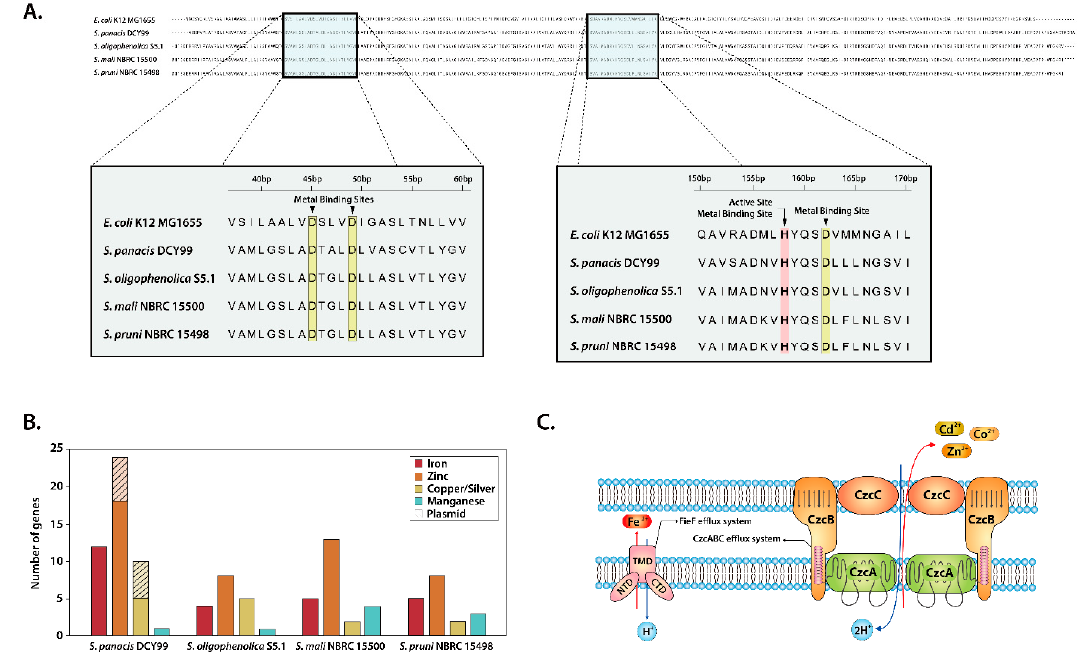
Table 1. Phosphate metabolism of S. panacis DCY99